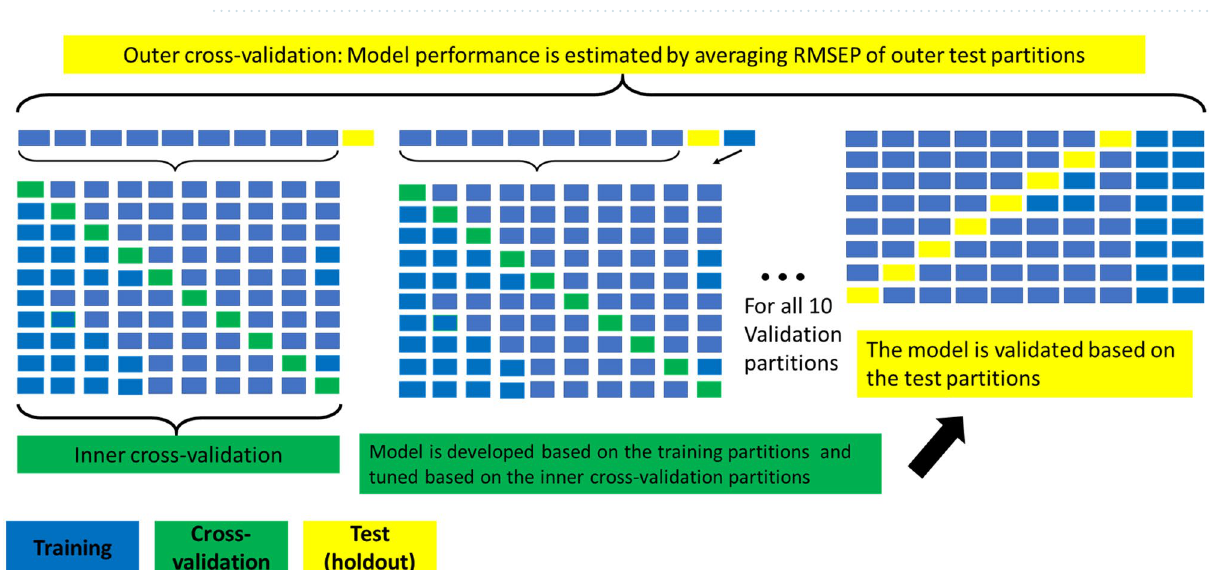
Figure 3. Overview of nested k-fold cross-validation. Model construction is done via training data. Model optimization was done via inner cross-validation. Model performance was tested via prediction on the test